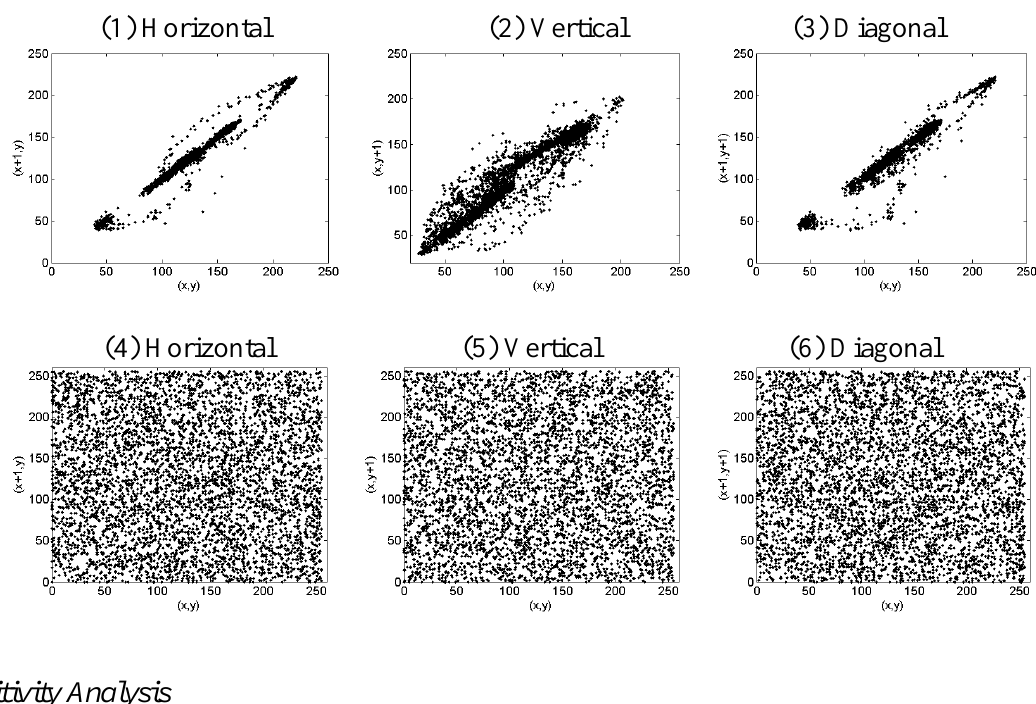
Figure 4. Correlation of the adjacent pixels (1–3)are plaintext and (4–6) are